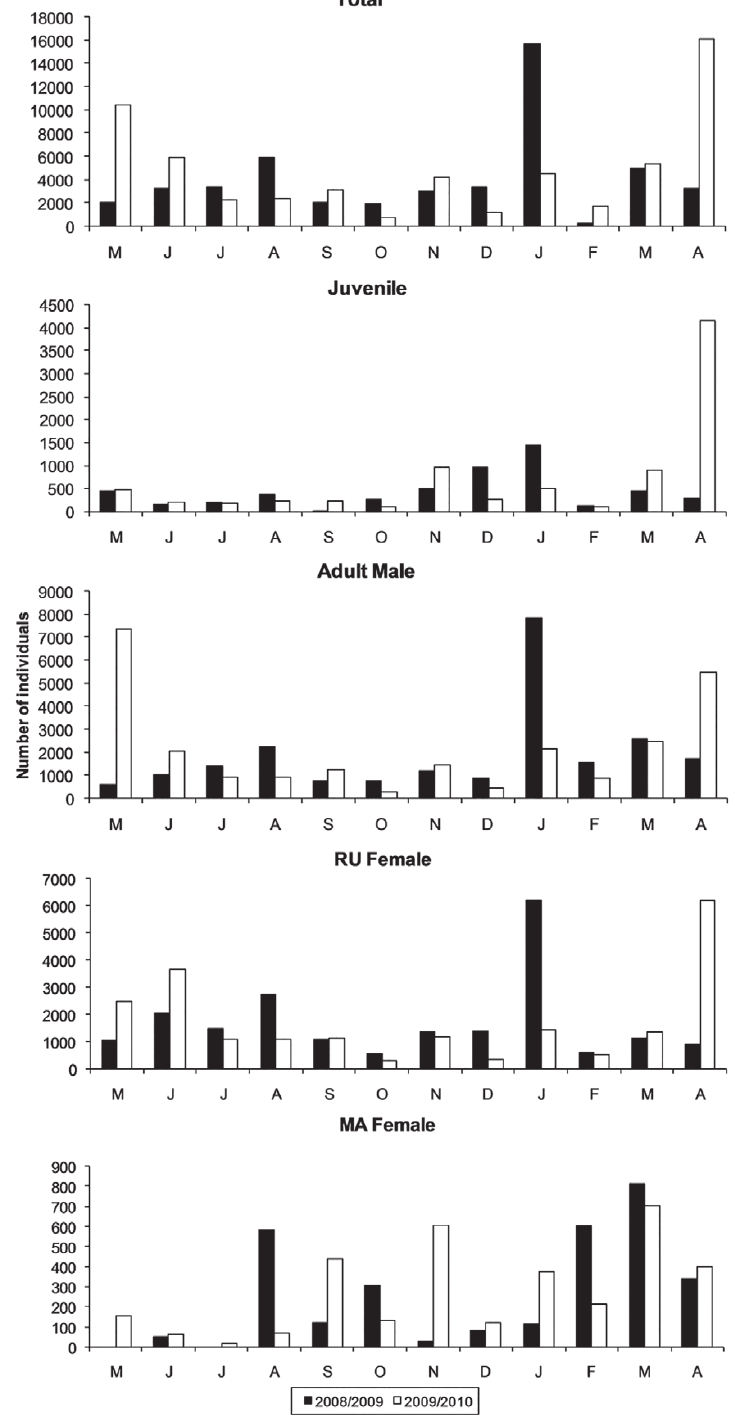
Fig. 4 - Number of individuals in total, juvenile, adult male, adult female with rudimentary ovaries (RU) and reproductive females (MA) of Xiphopenaeus kroyeri sampled in the Santos Bay from May 2008 through April 2010. Each graphic indicates a different y-scale to facilitate visual